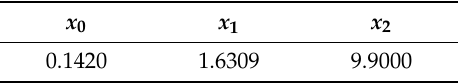
Table 1. Estimation result of parameters of the CNMP